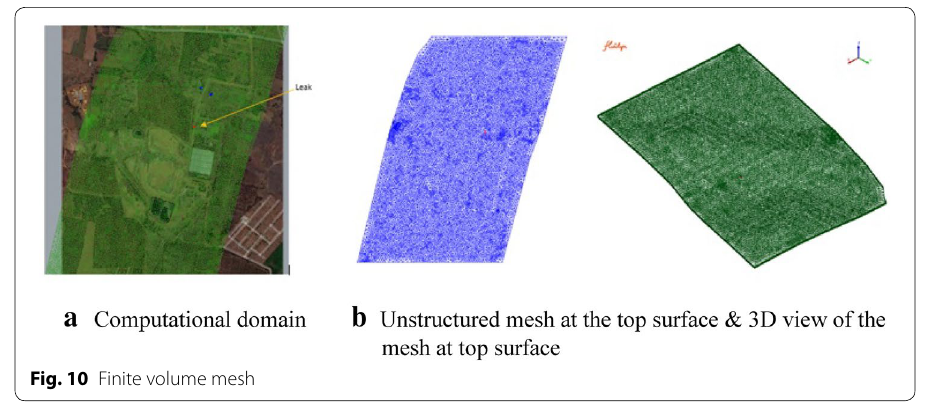
Fig. 10 Finite volume mesh